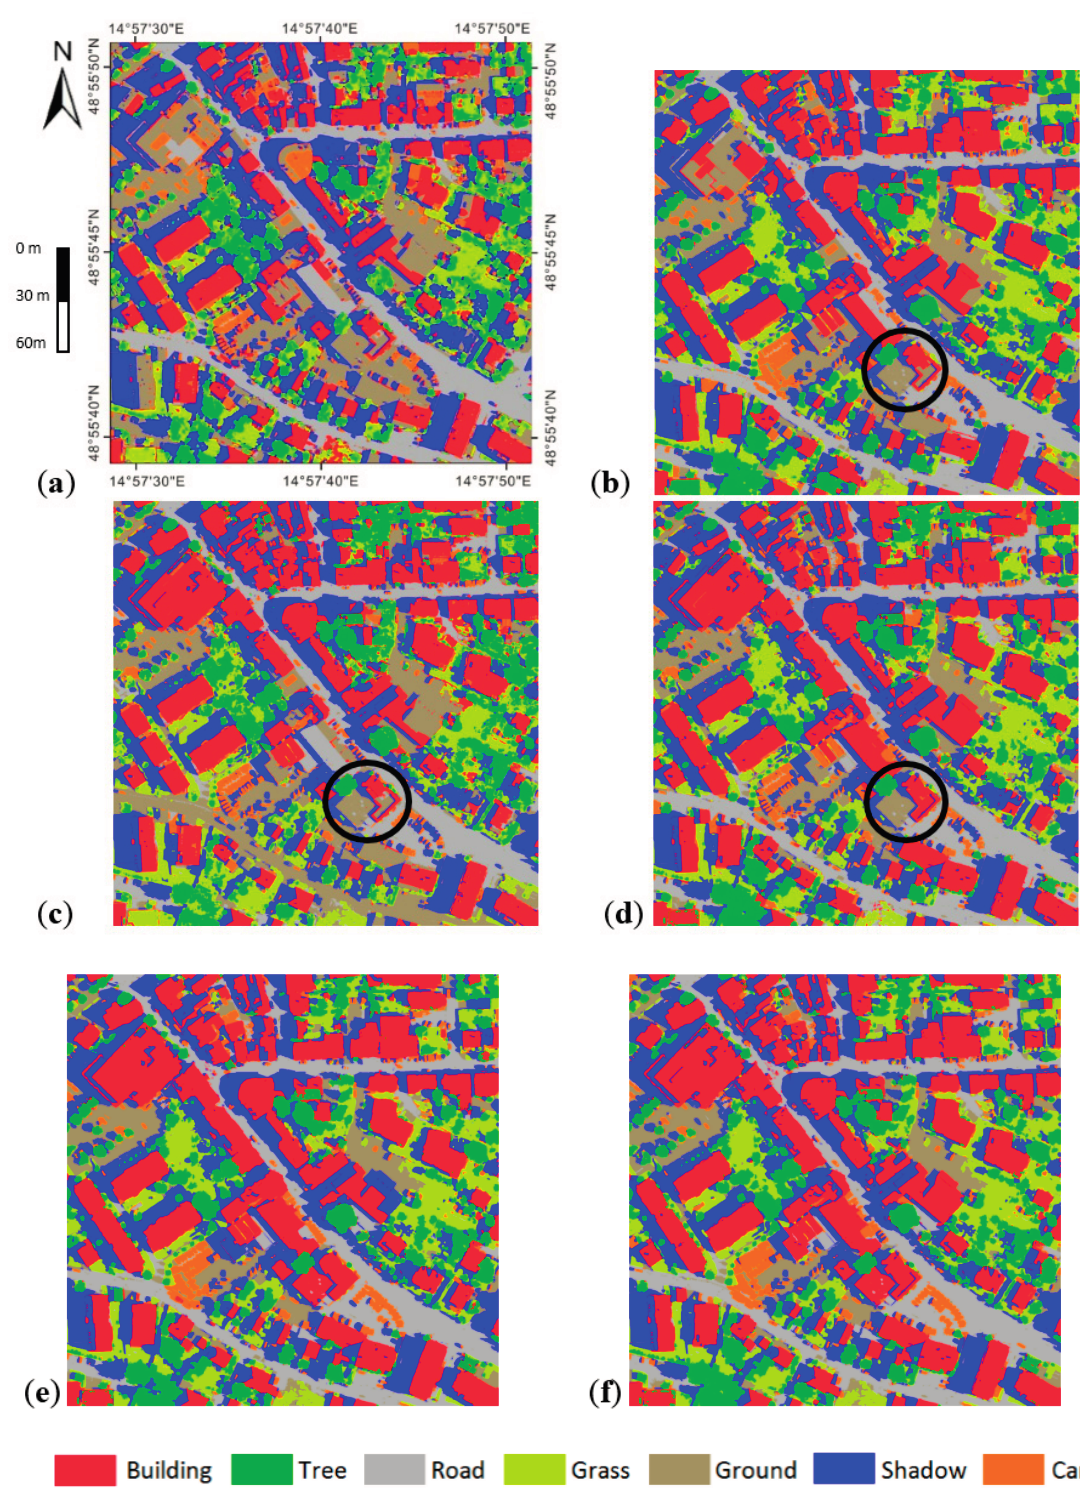
Figure 8. The classification maps of Test Dataset 1 using PCA combined with different spatial features. ( a ) Using spectral features only (PCA); ( b ) PCA + DMP; ( c ) PCA + height; ( d ) PCA + normalized DSM (nDSM); ( e ) PCA + DMTHP with a regular interval radius sequence; ( f ) PCA + DMTHP with adaptive radius selection (the black circles are explained in the